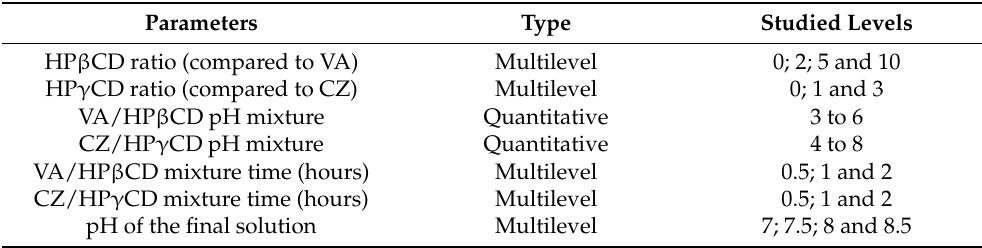
Table 6. Parameters studied for their impact on the precipitation of ceftazidime (CZ)/vancomycin (VA) mixture solution. HP β CD: 2-hydroxypropyl- β -cyclodextrin; HP γ CD: 2-hydroxypropyl- γ - cyclodextrin. Parameters Type Studied Levels HP β CD ratio (compared to VA) Multilevel 0; 2; 5 and 10 HP γ CD ratio (compared to CZ) Multilevel 0; 1 and 3 VA/HP β CD pH mixture Quantitative 3 to 6 CZ/HP γ CD pH mixture Quantitative 4 to 8 VA/HP β CD mixture time (hours) Multilevel 0.5; 1 and 2 CZ/HP γ CD mixture time (hours) Multilevel 0.5; 1 and 2 pH of the final solution Multilevel 7; 7.5; 8 and